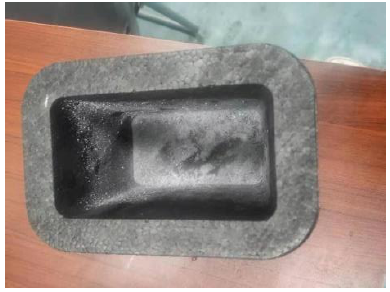
Figure 6. Heat insulation foam box.